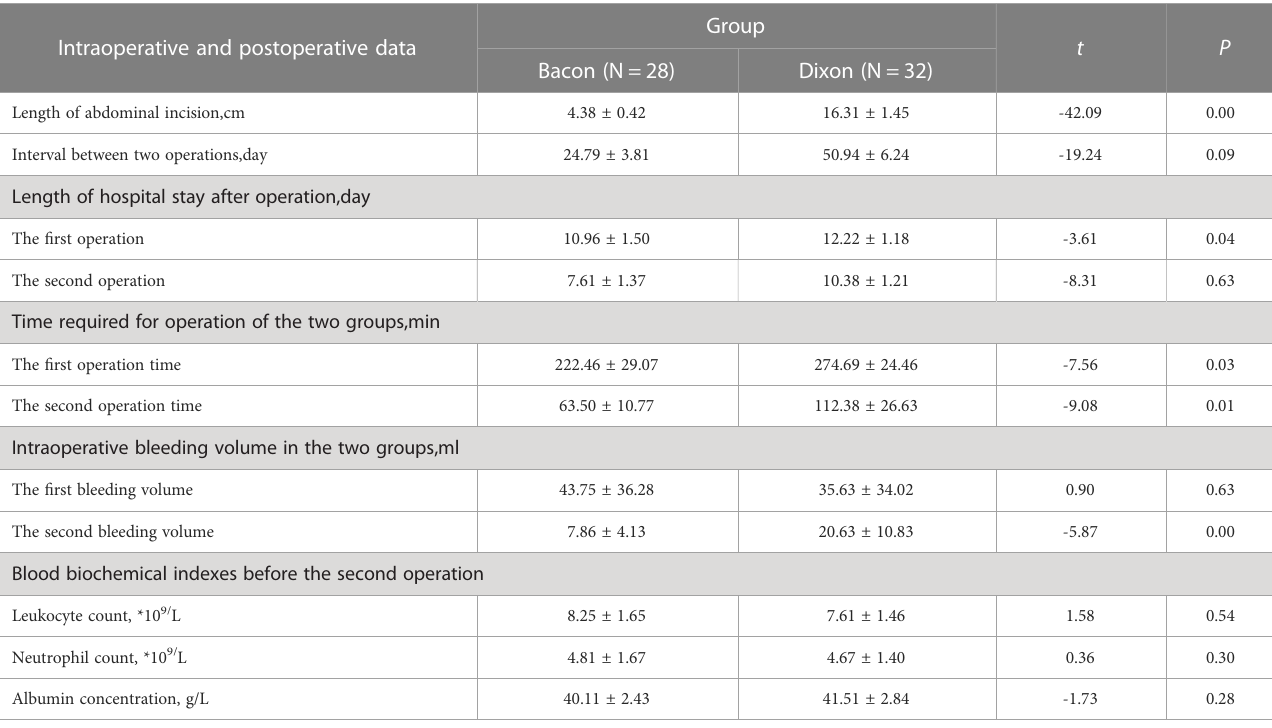
TABLE 2 Data on patient hospitalizations and